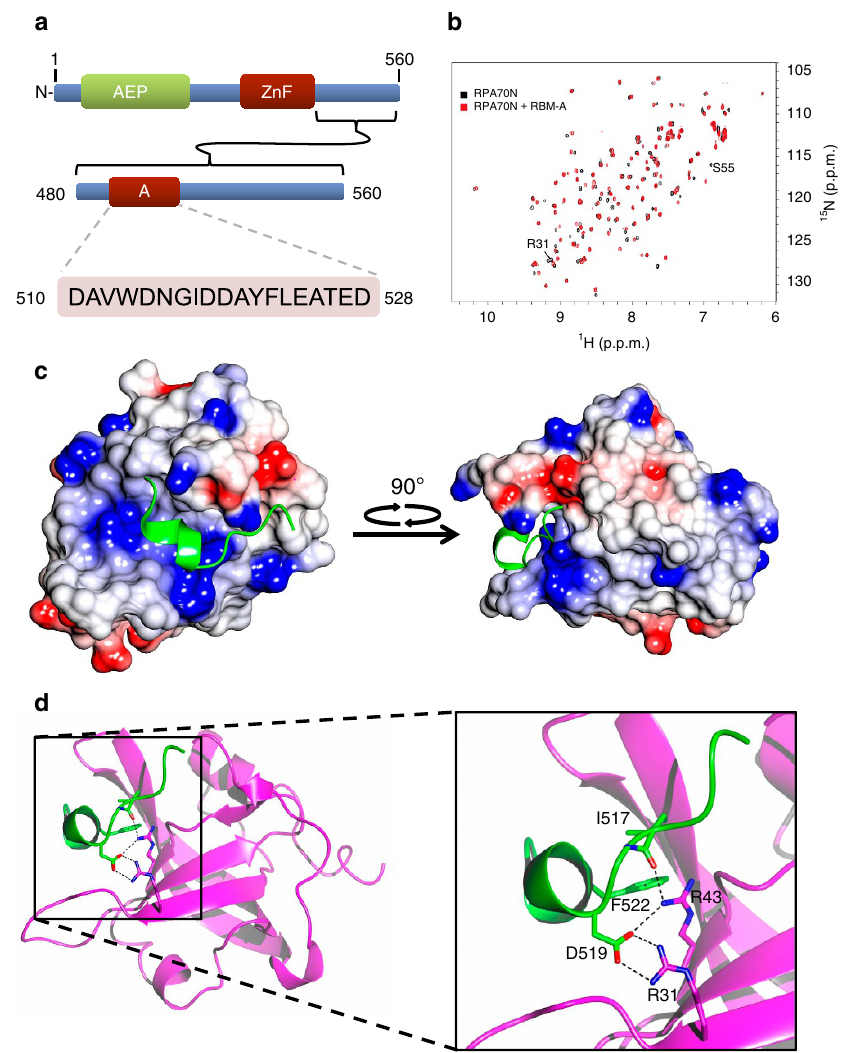
Figure 1 | PrimPol possesses a conserved RBM that binds to the basic cleft of RPA70N. ( a ) Schematic showing the sequence of PrimPol’s RBM-A (residues 510–528), located in the C-terminal RBD (residues 480–560). ( b ) 15 N- 1 H HSQC spectra showing RPA70N in the absence (black) or presence (red) of twofold molar excess of unlabelled RBM-A peptide. ( c ) Electrostatic surface model of RPA70N with RBM-A (green) bound in the basic cleft. Basic and acidic surfaces are coloured blue and red, respectively. ( d ) Key stabilizing interactions of RBM-A (green) in the RPA70N basic cleft (purple). RBM-A binds between b sheets in the b barrel of RPA70N. Of particular importance for binding are the electrostatic interactions of D519 with the side chains of two arginines (R31 and R43) in the RPA70N basic